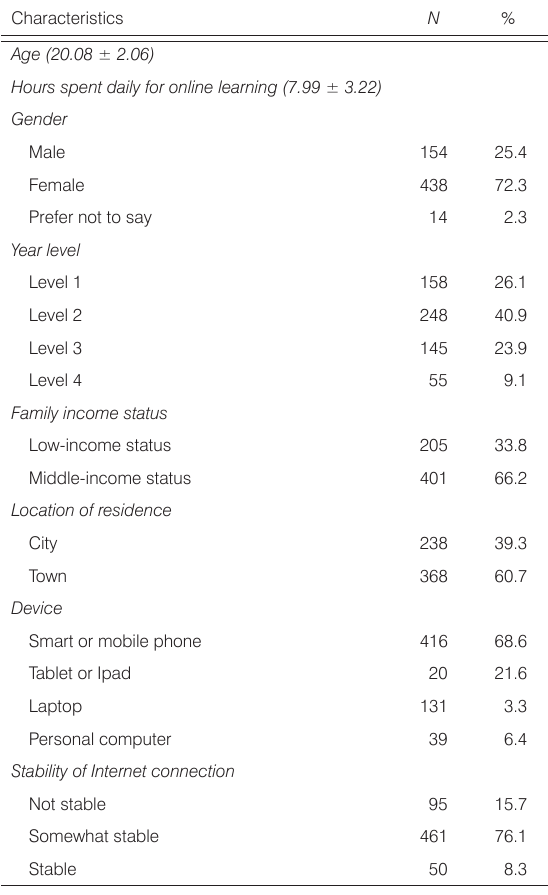
Table 1. Students’ characteristics ( n =